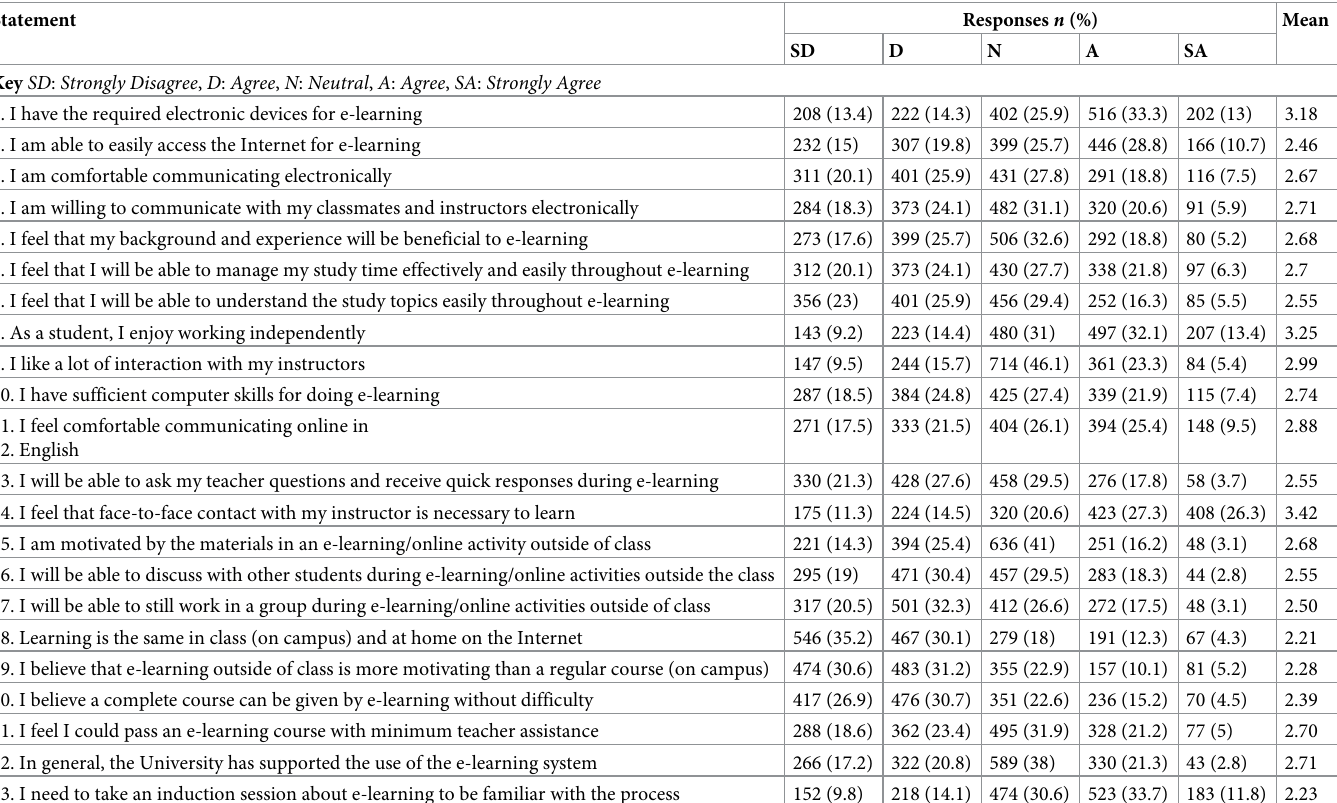
Table 3. Initial stage/statements about e-learning ( n =